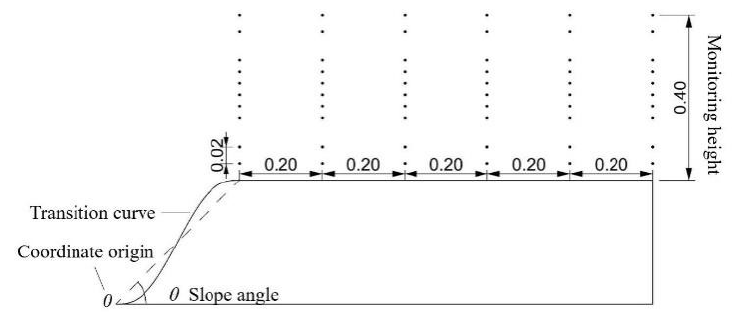
where U x is the wind speed at height z , U r is the wind speed (3 m/s) at a reference height z r = 10 m (scale height 0.007 m), the gradient wind height wind speed is 5.3 m/s, and α is set as 0.15.